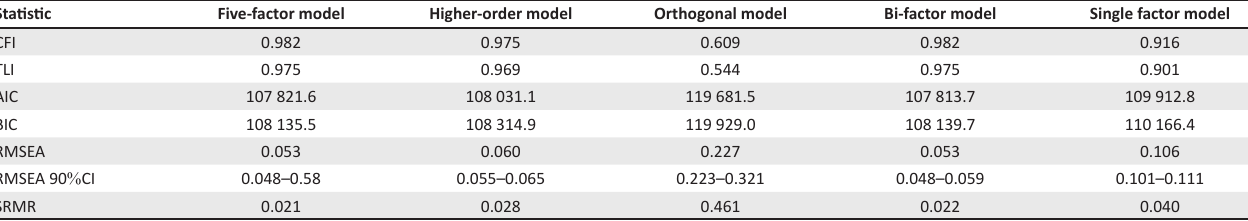
TABLE 6: Fit statistics.